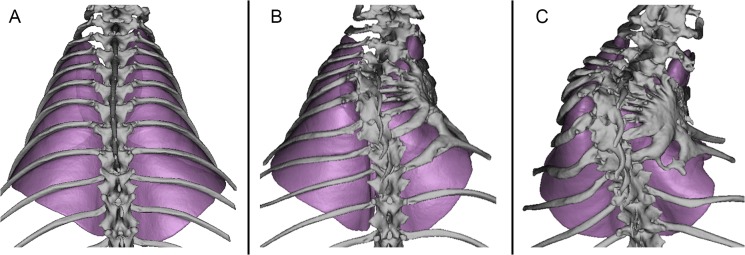
CT image reconstructions.Reconstructions are from 28 week post-natal age demonstrating deformity of thorax and lungs of a representative (A) Normal, (B) Moderate, and (C) Severe rabbit. The inferior surface of the lungs is colored orange.